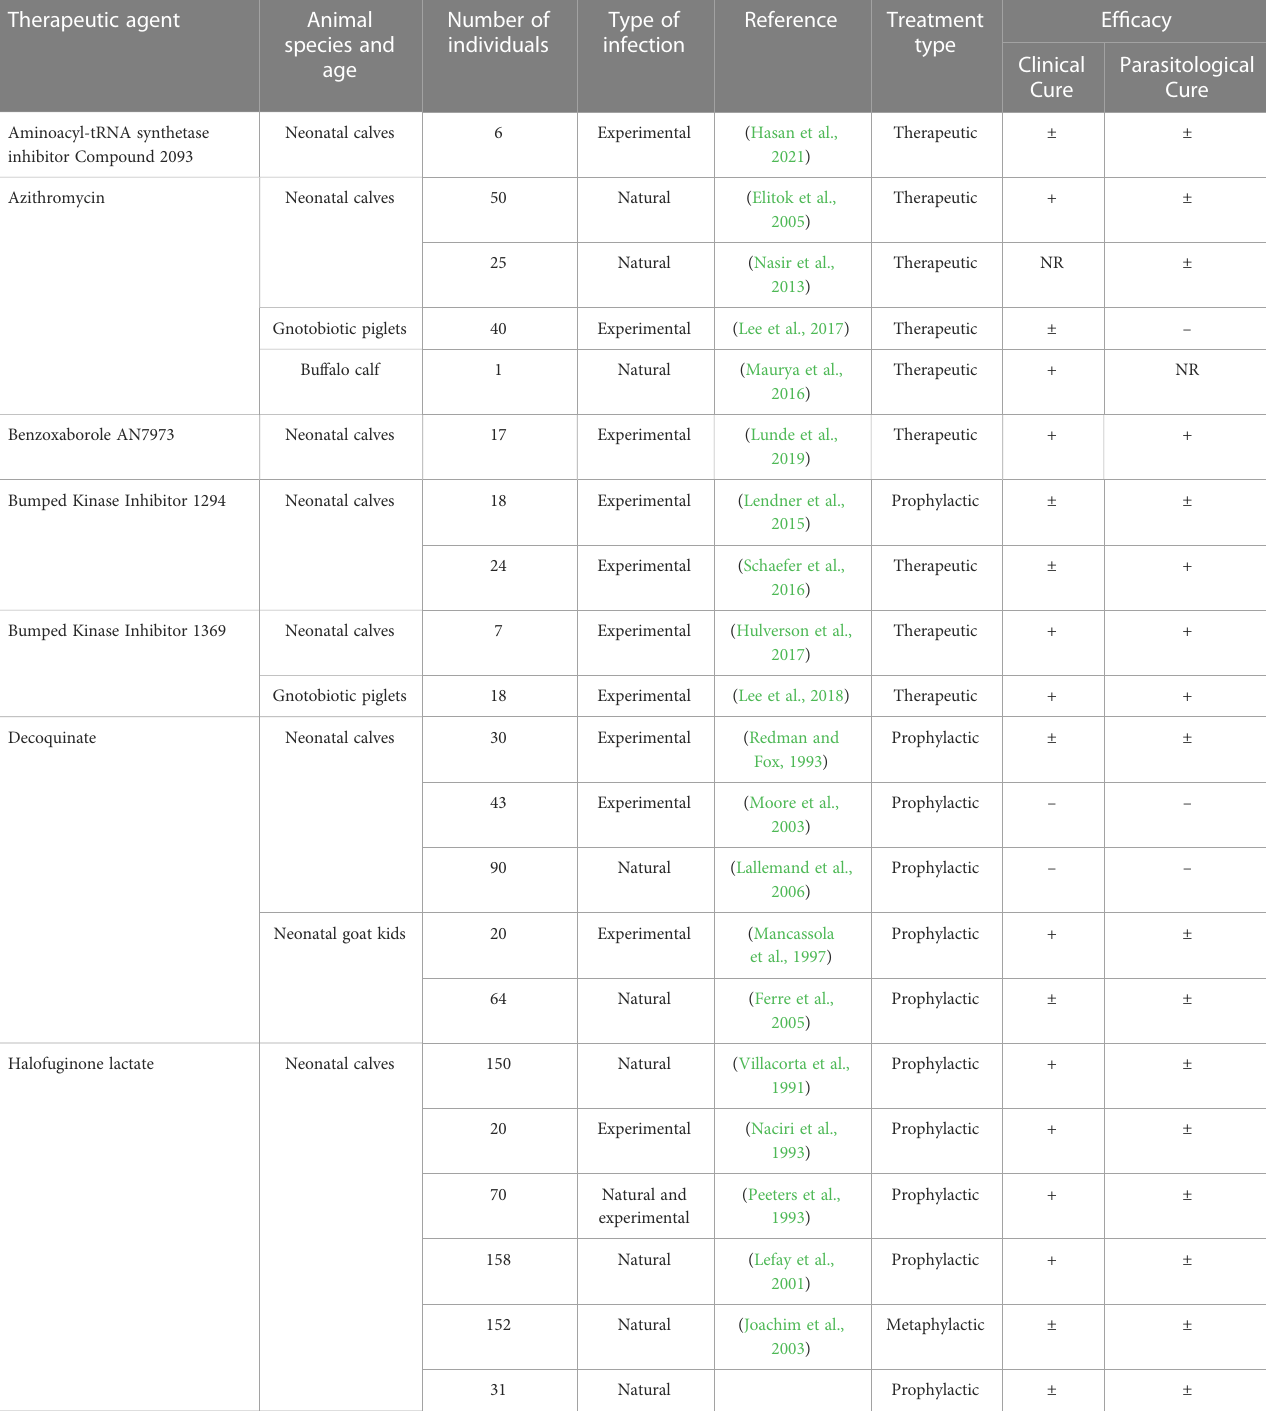
TABLE 4 Anti-cryptosporidial ef fi cacies of various antimicrobial and novel treatments in farm animals and natural host animal models. Therapeutic